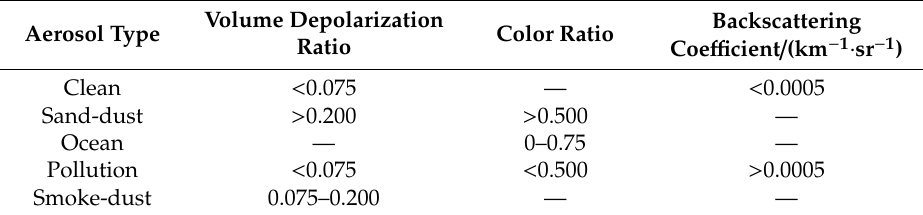
Table 1. Aerosol type classification criteria.